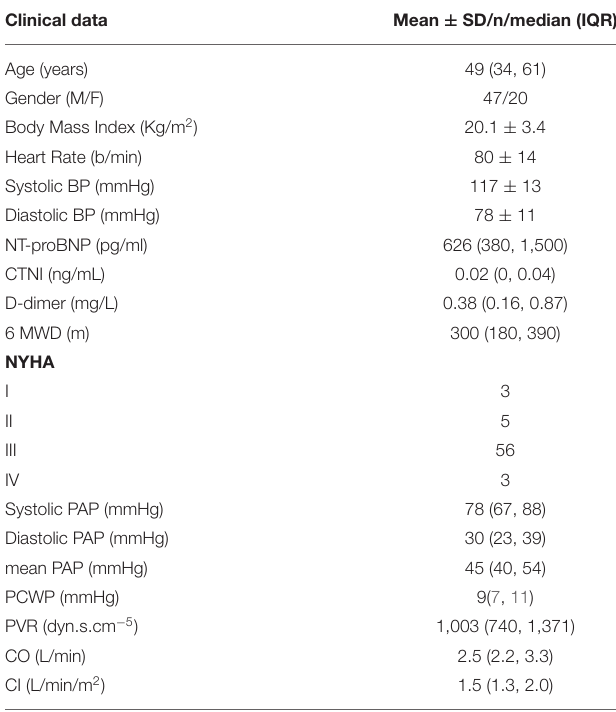
TABLE 1 | Baseline demographic and clinical data of patients with CTEPH. Clinical